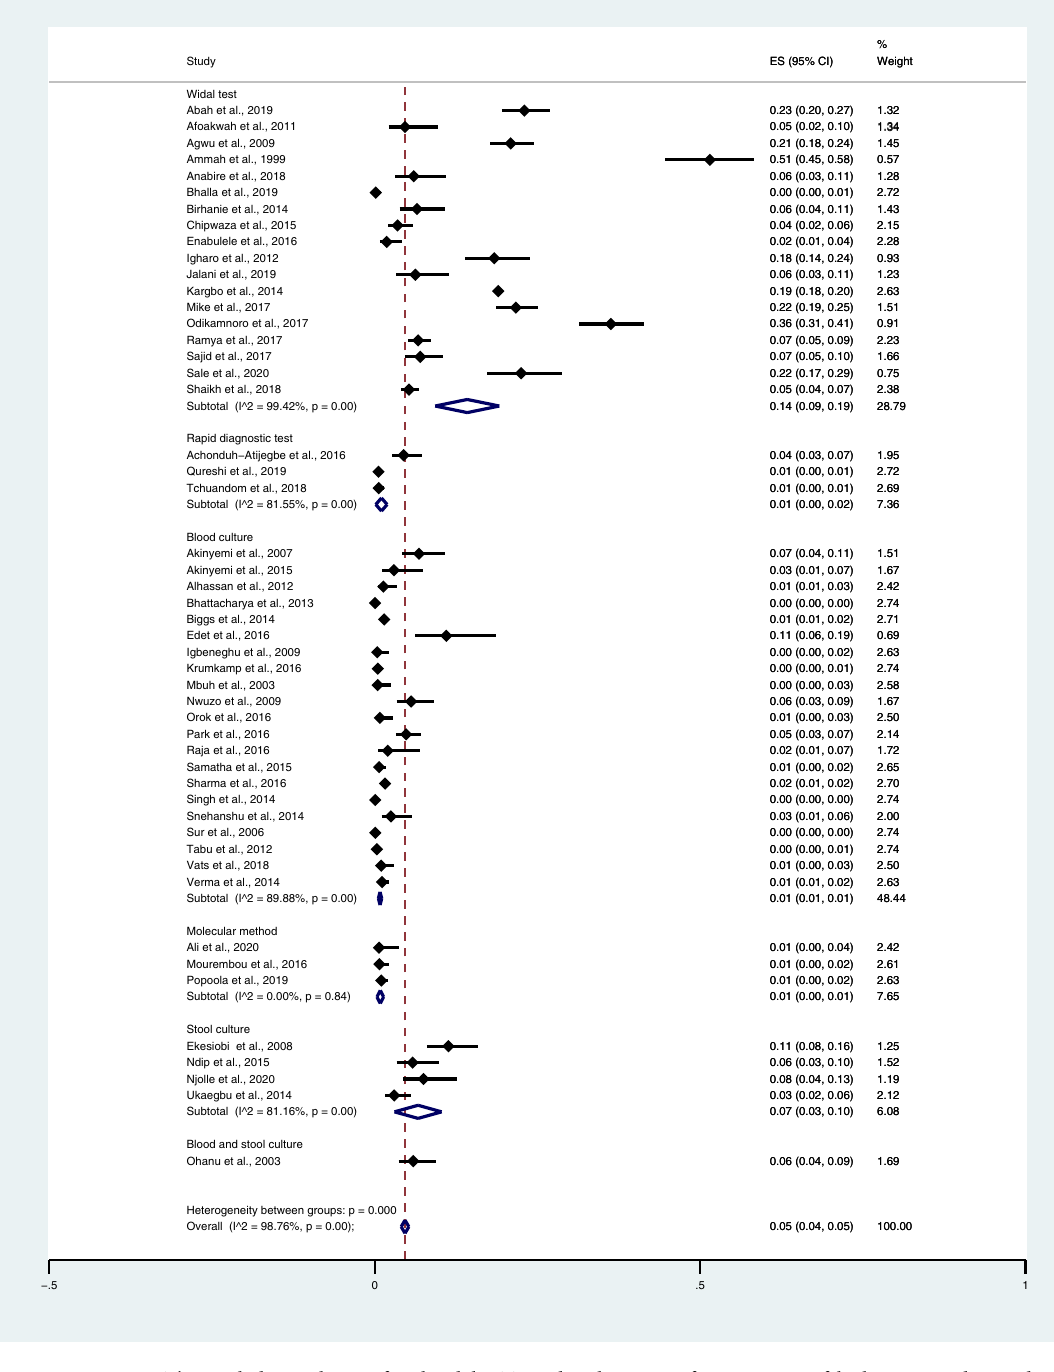
Figure 2. The pooled prevalence of typhoidal/NTS and malaria co-infection among febrile patients detected using diagnostic tests for Salmonella spp. ES proportion estimate (multiply 100 units for interpreted as prevalence estimate), CI confidence